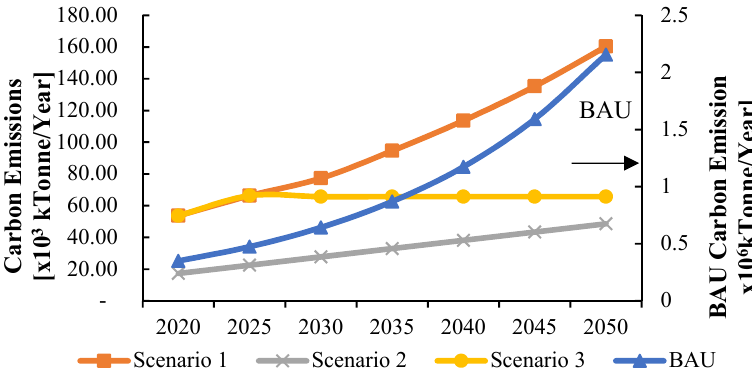
Figure 6. Energy/technology mix for Scenario 3 (CO 2 cap of 65704 (15% reductions of Scenario 1) by 2030 maintained till 2050 and ban on oil combustion for power generation).